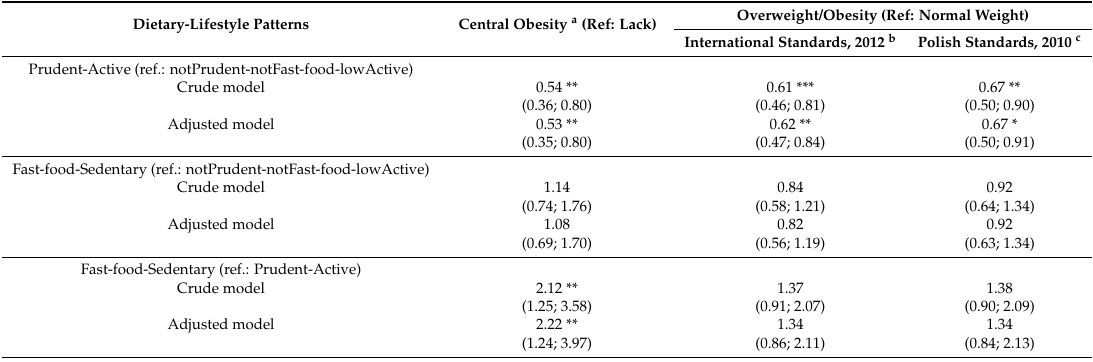
Table 3. Odds ratios (95% confidence interval) for adiposity measures by dietary-lifestyle patterns. Dietary-Lifestyle Patterns Central Obesity a (Ref: Lack) Overweight/Obesity (Ref: Normal Weight) International Standards, 2012 b Polish Standards, 2010